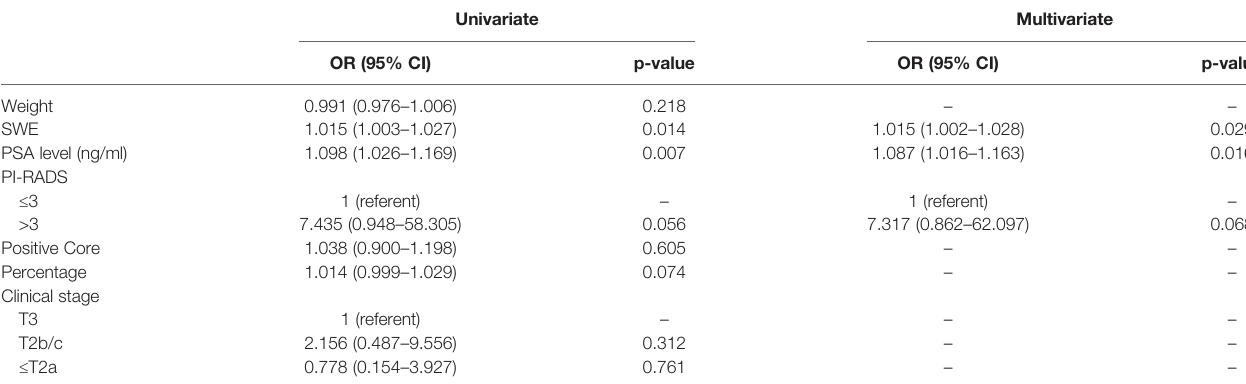
TABLE 4 | Univariate and multivariate logistic regression models to predict upgrading from biopsy GS ≤ 7 (3 + 4) to GS ≥ 7 (4 + 3) at radical prostatectomy. Univariate